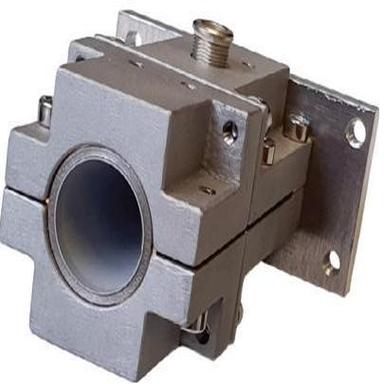
Operation of the Alberich ACFT featuring a thermionic cathode.